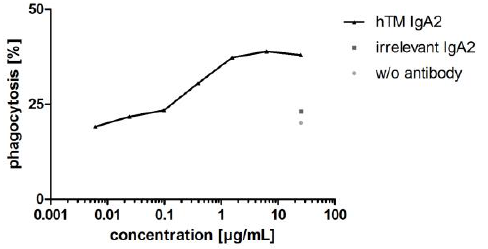
Figure 8. Antibody-dependent cellular phagocytosis (ADCP) mediated by hTM IgA2 antibodies against BT-474 target cells. Monocyte-derived macrophages (MDM) were used as effector cells for ADCP assays. negative controls did not result in phagocytosis of target cells. Mean values of duplicates are shown. hTM IgA2 mediated phagocytosis of the BT-474 (Her2 +++) target cell line. hOM IgA2 irrelevant matched isotype or medium without antibody negative controls did not result in phagocytosis of target